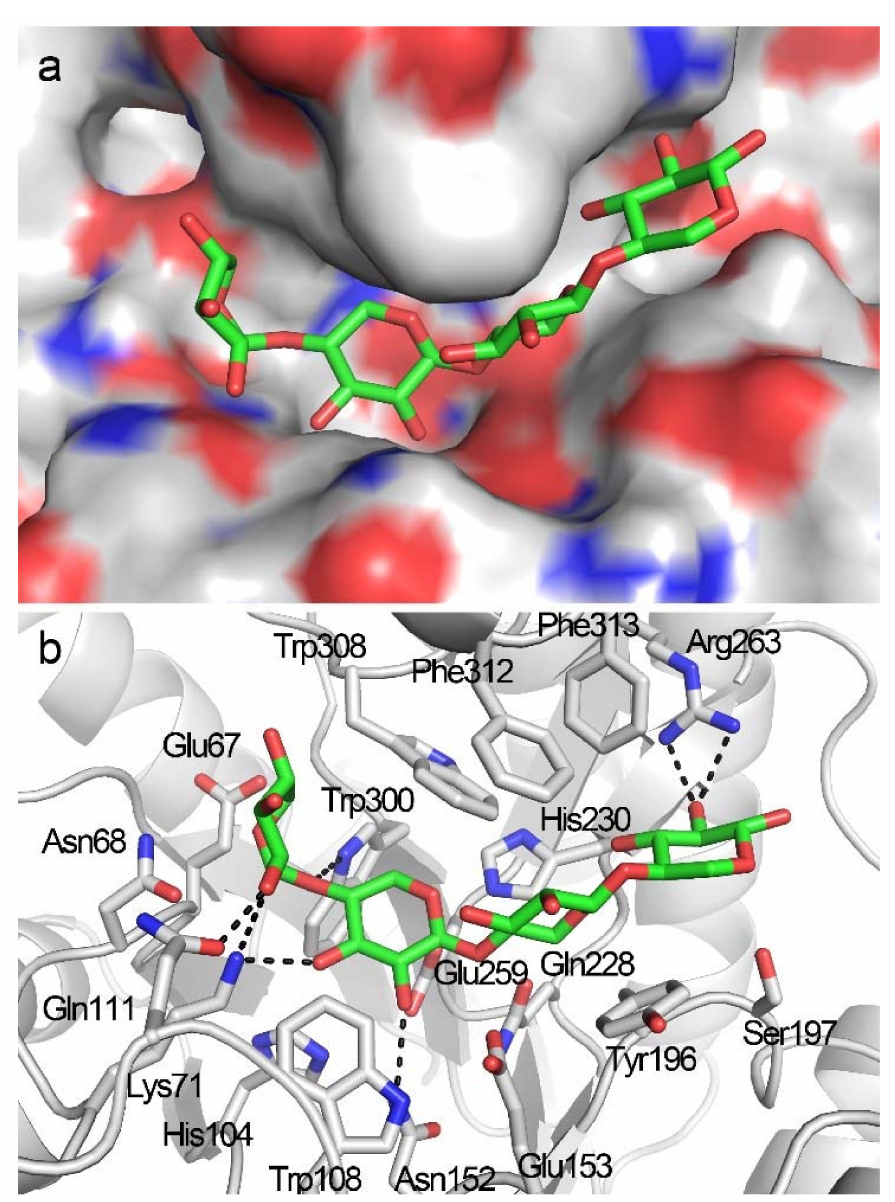
Figure 5. Docking structure of TmxB in complex with X4. ( a ) The overall binding location of X4 in the active-site cleft of TmxB. ( b ) Interaction details between TmxB and X4. The putative hydrogen bonds are indicated by black